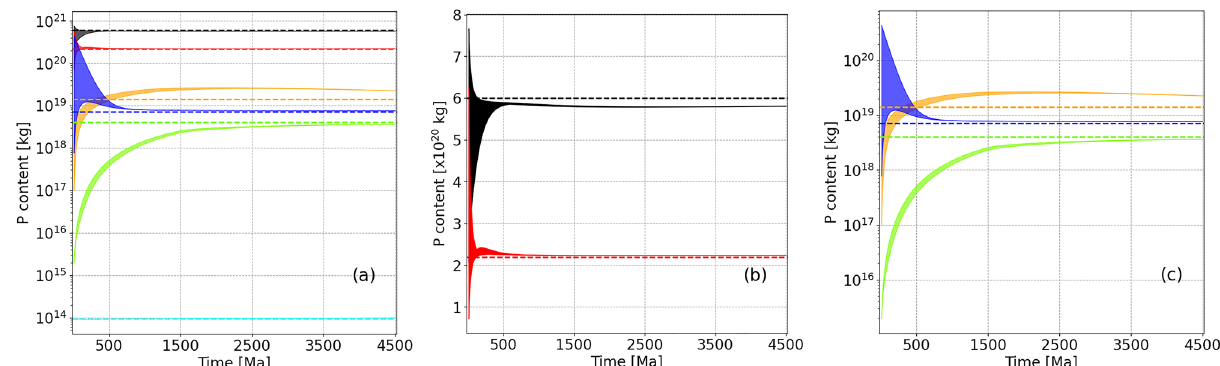
Figure 2. Evolution of P reservoirs in the main model assuming an initial 10% residual chondritic P inventory randomly seeded across BSE reservoirs across 50 randomly seeded model runs. ( a ) All reservoirs (Black: LM, Red: UM, Orange: CC, Blue: OC, Green: MS, and Turquoise: Oceans). ( b ) Expanded view of UM and LM reservoir evolution. ( c ) Expanded view of CC, MS and OC reservoirs. Dotted lines represent estimated